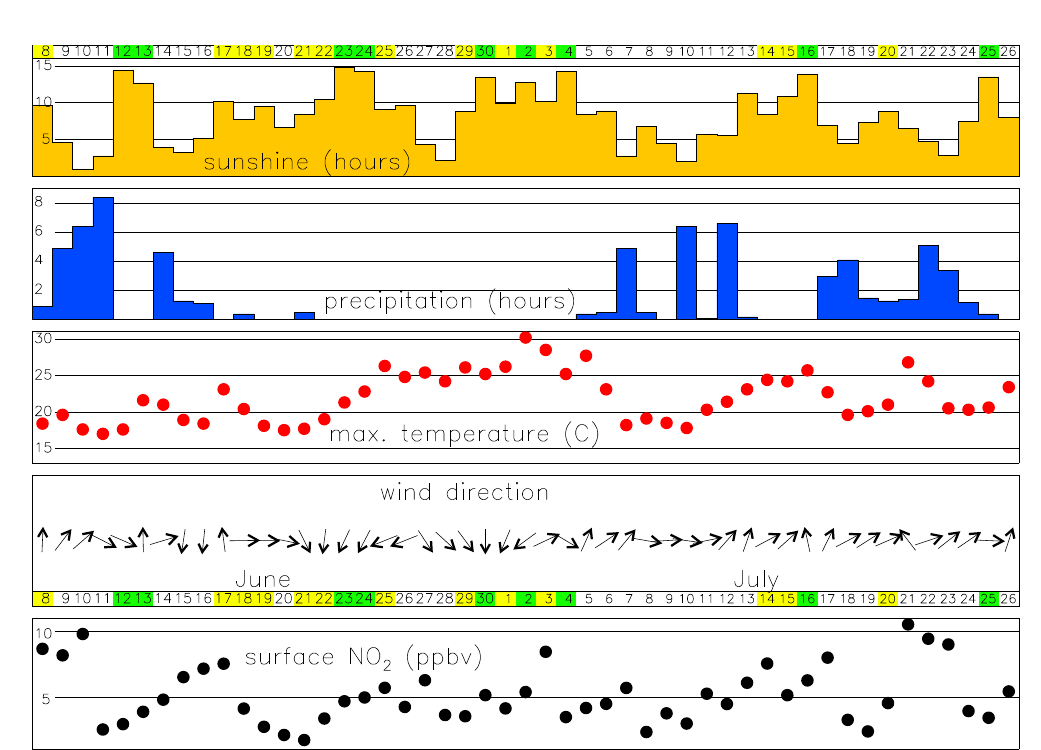
Fig. 6. Overview of meteorological conditions during the CINDI campaign period. From top to bottom: hours of sunshine, hours of precipitation, daily maximum temperature, wind direction (pointing up means winds coming from the south), and average daytime surface level NO 2 derived from the in-situ instruments of RIVM, IUP Bremen and EMPA. Category A days (see text) are coloured green, category B days are coloured